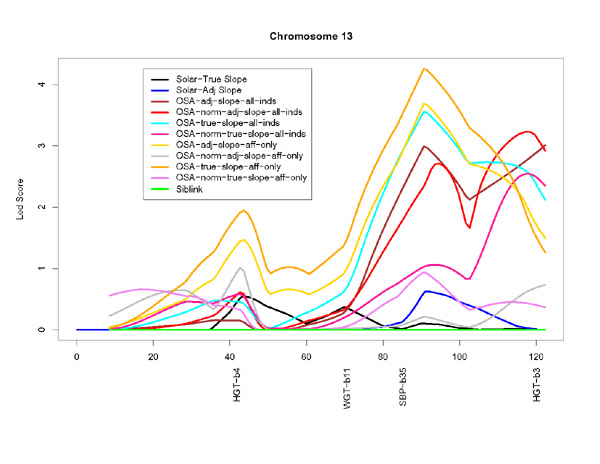
LOD score curves for linkage results on chromosome 13. The x-axis is in cM along with the location of genes on that chromosome. SOLAR curves are for the normalized SBP slopes. The SIBLINK curve shows the ASP LOD score for HBP.